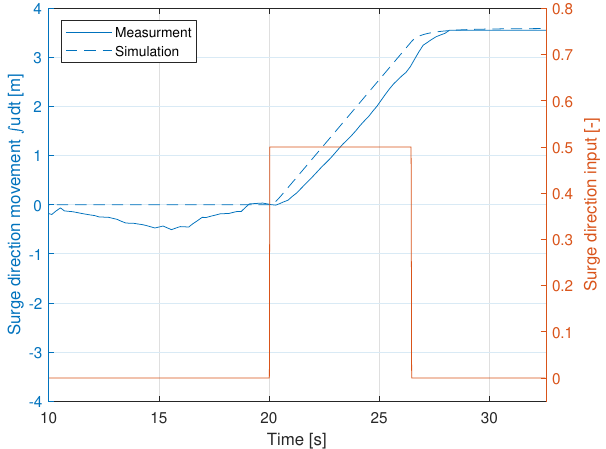
Figure 5. Simulation model and experimental measurements for the surge-direction with positive 50% open-loop input. The error between these is shown as the blue bar at an input of 0.5 in Figure 6.